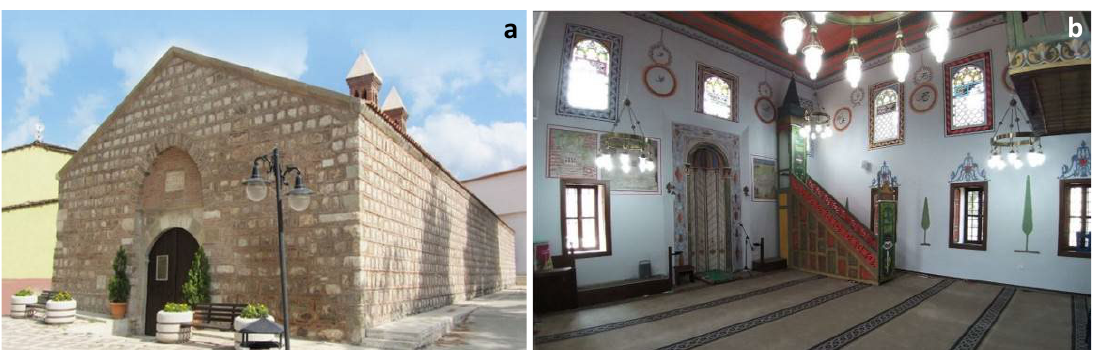
Figure 5a Mihal Gazi Caravenserai 15 th century (photo:authors); b Kasımlar Mosque -17th century (photo:H.Yıldız).